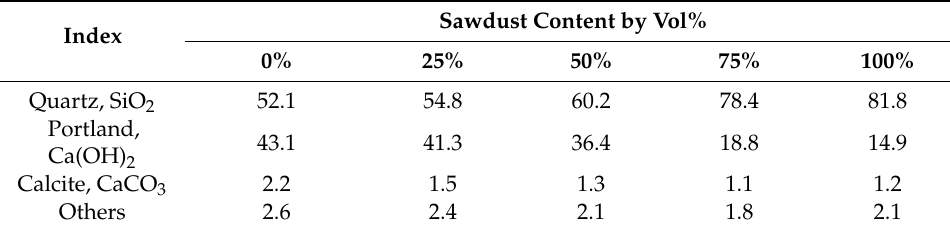
Figure 12. XRD analysis of the prepared concrete with various sawdust contents. Table 5. XRD peak amount by wt.%.